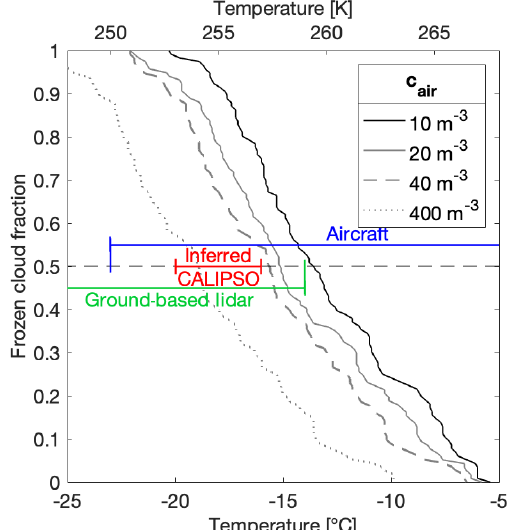
Figure 12. Frozen cloud fraction as a function of temperature de- rived from all 88 samples from this study at four different critical INP concentrations necessary for cloud glaciation, namely 10, 20 and 40m − 3 . The frozen cloud fraction was further estimated using the c ∗ parameterization to 400m − 3 (see text). The aircraft (blue), air inferred CALIPSO (red) and ground-based lidar (green) tempera- ture ranges for 50% frozen cloud fractions are adapted from McCoy et al.